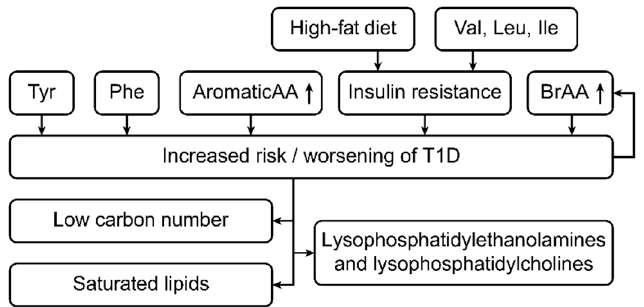
branched-chain amino acids (BRAAs). In contrast, if a patient already has type 1 diabetes, a high BRAA concentration worsens the disease state [23,33,34]. Additionally, in type 1 diabetes, a high-fat [23,33,34]. In addition, type 1 diabetes is associated with increased levels of low-carbon-number saturated lipids, lysophosphatidylethanolamine and lysophosphatidylcholine